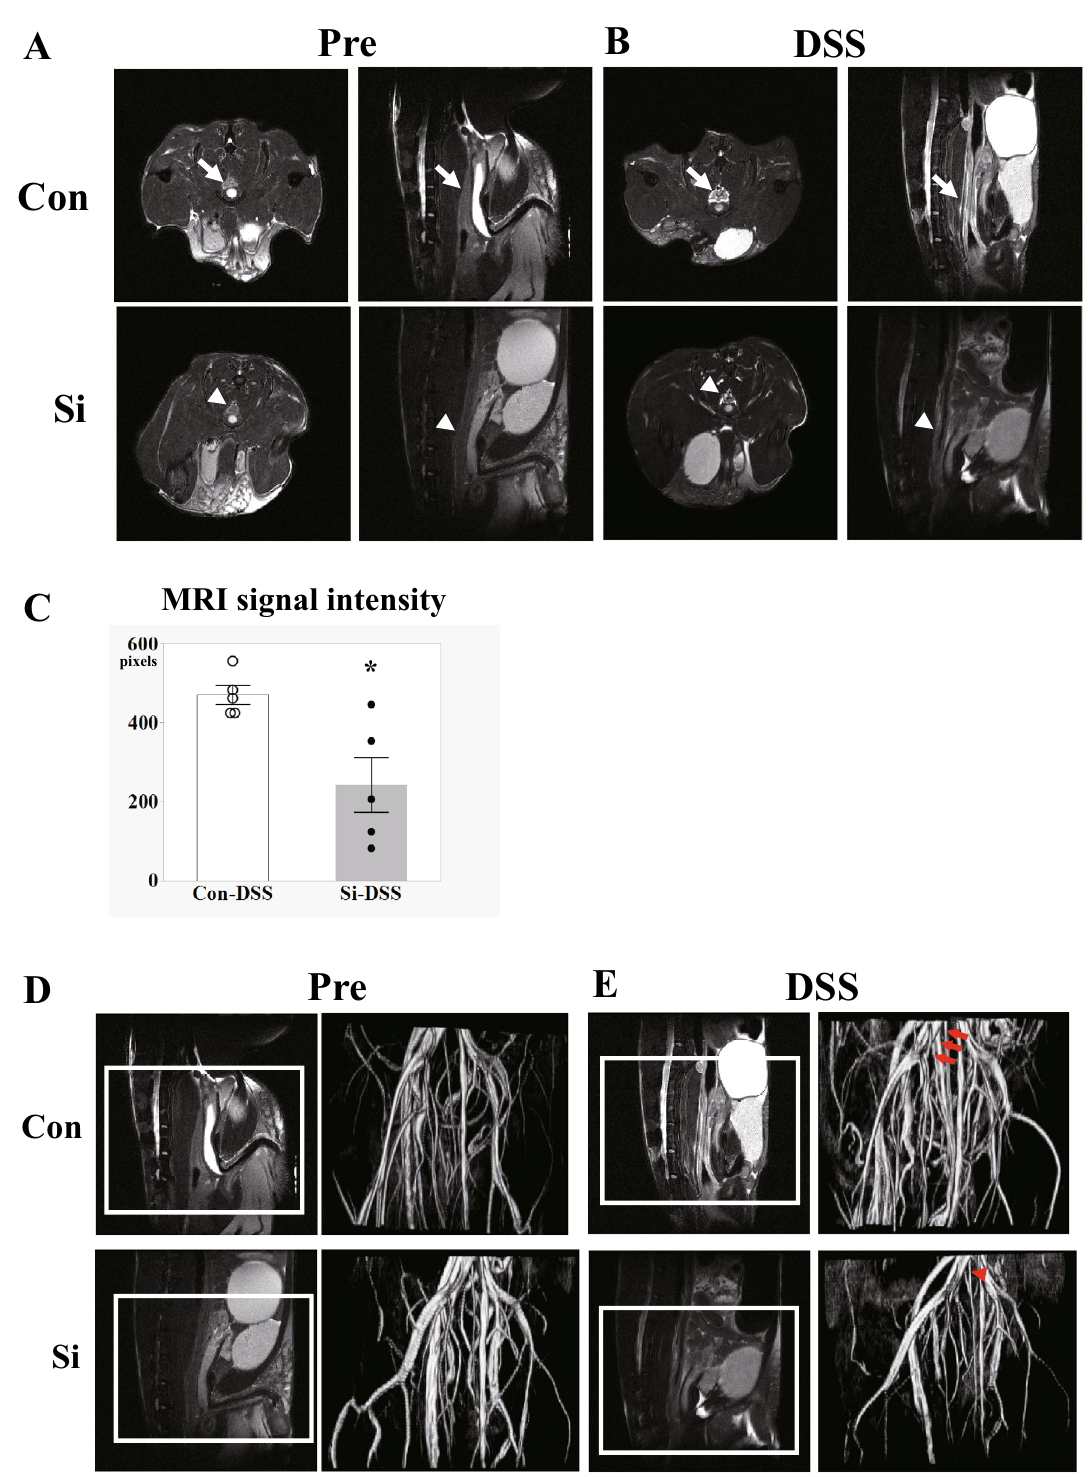
Figure 2. Si-based agent mitigated the inflammation of large intestine. Analysis of inflammation in the colon, using MRI and MRA. ( A , B ) Representative T 2 weighted axial (left) and sagittal images (right) of the colon in the control (upper) and Si-based agent-treated groups (bottom) before treatment ( A ) and 5 days after 5% DSS treatment ( B ). Pre pretreatment, DSS 5 days after DSS treatment, Con control group, Si Si group. The colon of a control mouse (arrow) and an Si-based agent-treated mouse (arrowhead). ( C ) Average number of high signal intensity pixels in the axial image of the colon at the level of the pubis. White: Con-DSS group. Black: Si-DSS group. Data are expressed as mean ± SEM of five mice per group. * p < 0.05 vs. Con-DSS, determined by Student’s paired t -test. ( D , E ) Representative T 2 weighted sagittal images of the colon (left) and images of blood vessels around the colon (right) in the control (upper) and Si-based agent-treated groups (bottom) before treatment ( D ) and 5 days after DSS treatment ( E ). ( D , E ) The colon of a control mouse (arrow) and an Si-based agent-treated mouse (arrowhead). Square: the subject of the blood vessel image around the colon. The abdominal aorta of a control mouse (arrow) and an Si-based agent-treated mouse